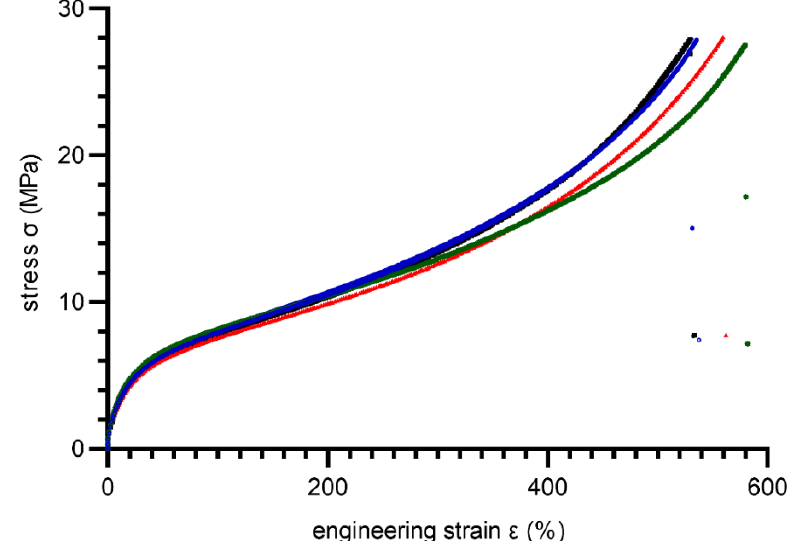
Figure 8. Stress–strain curves obtained during the tensile test for 90 ShA PUR material (solid lines represents different specimens, dots–measurement points after break). Table 1. Tensile test results analysis for 80 ShA and 90 ShA material configuration.